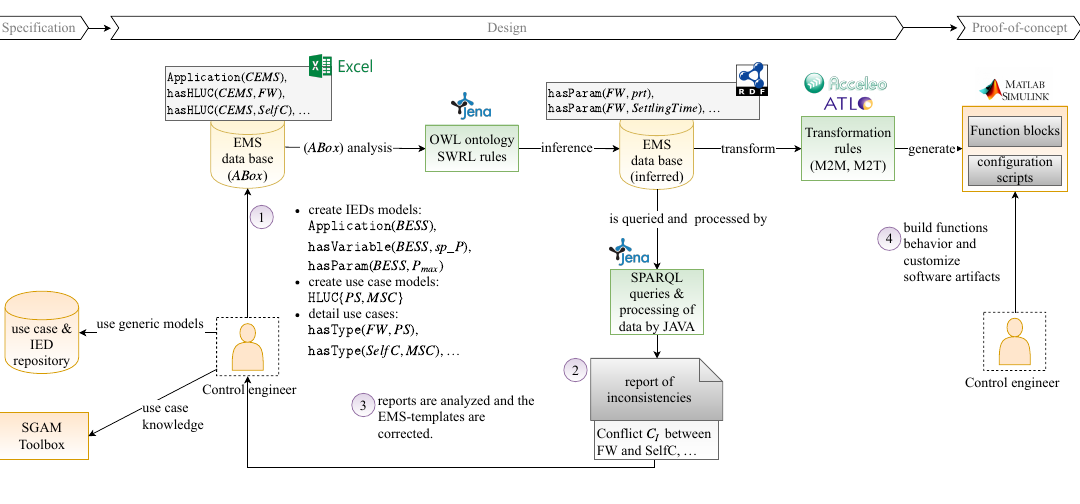
Figure 9. EMSOnto in practice by realizing the